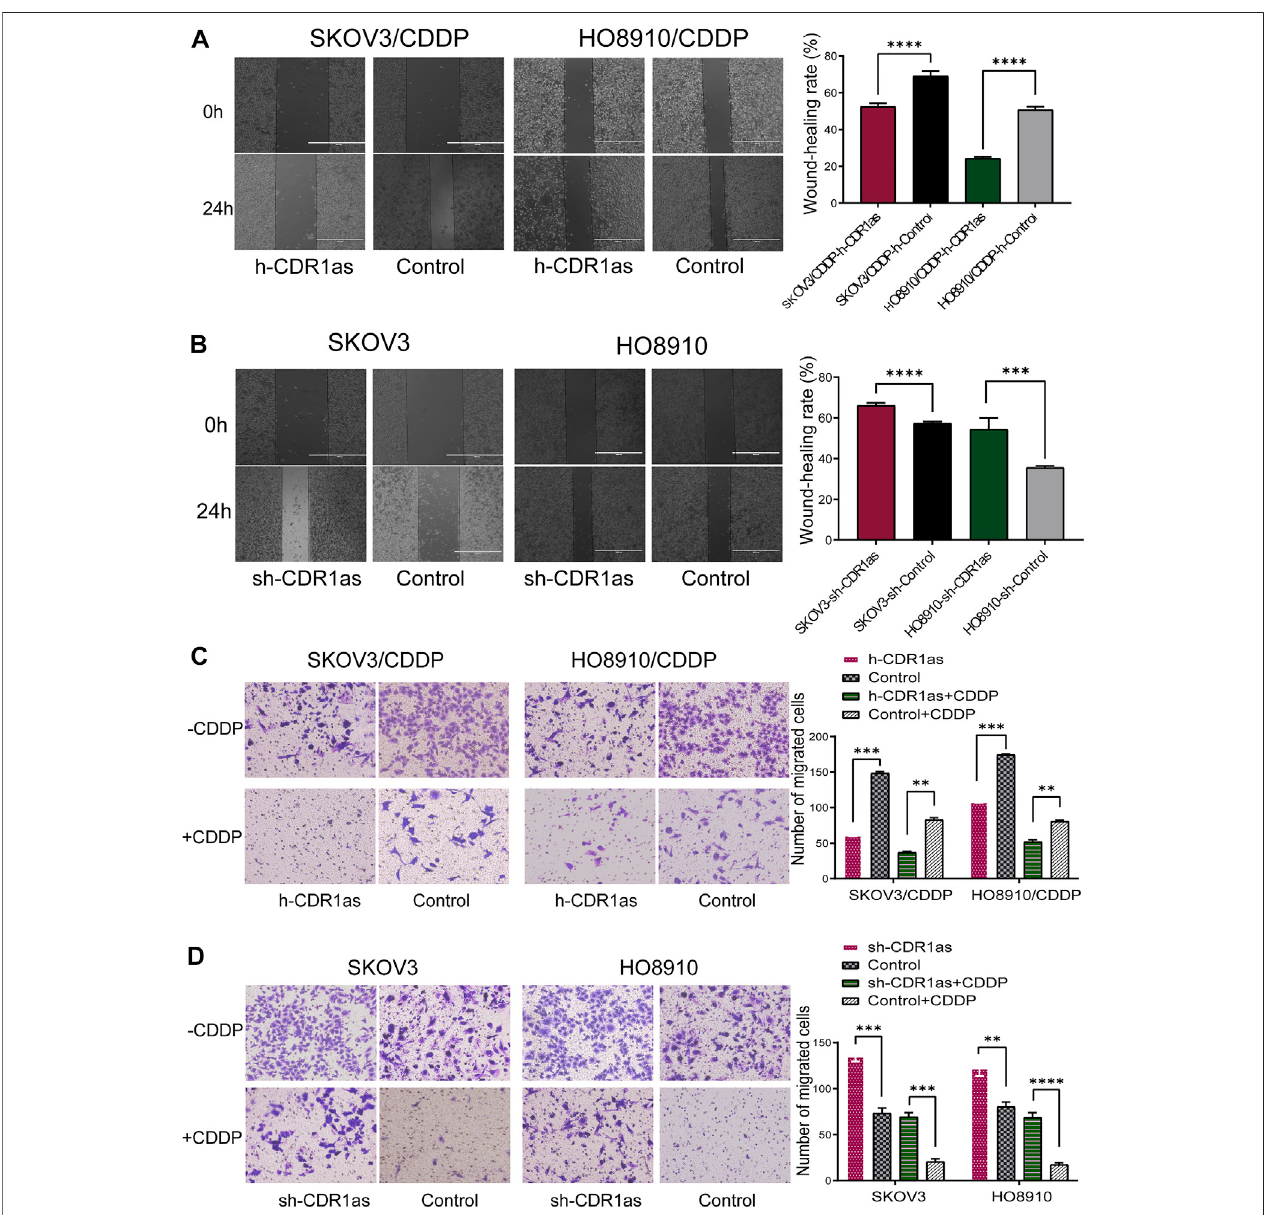
FIGURE 4 | CDR1as reduces the cell migration and invasion. (A,B) Wound healing assays detected the effect of CDR1as on cell migration. (C,D) Cell invasion analysisofCDDP-resistantand-sensitivecelllinesonCDR1asexpression.Theseresultswerepresentedasthemean±SDs.** p < 0.01,*** p < 0.001and**** p < 0.0001.